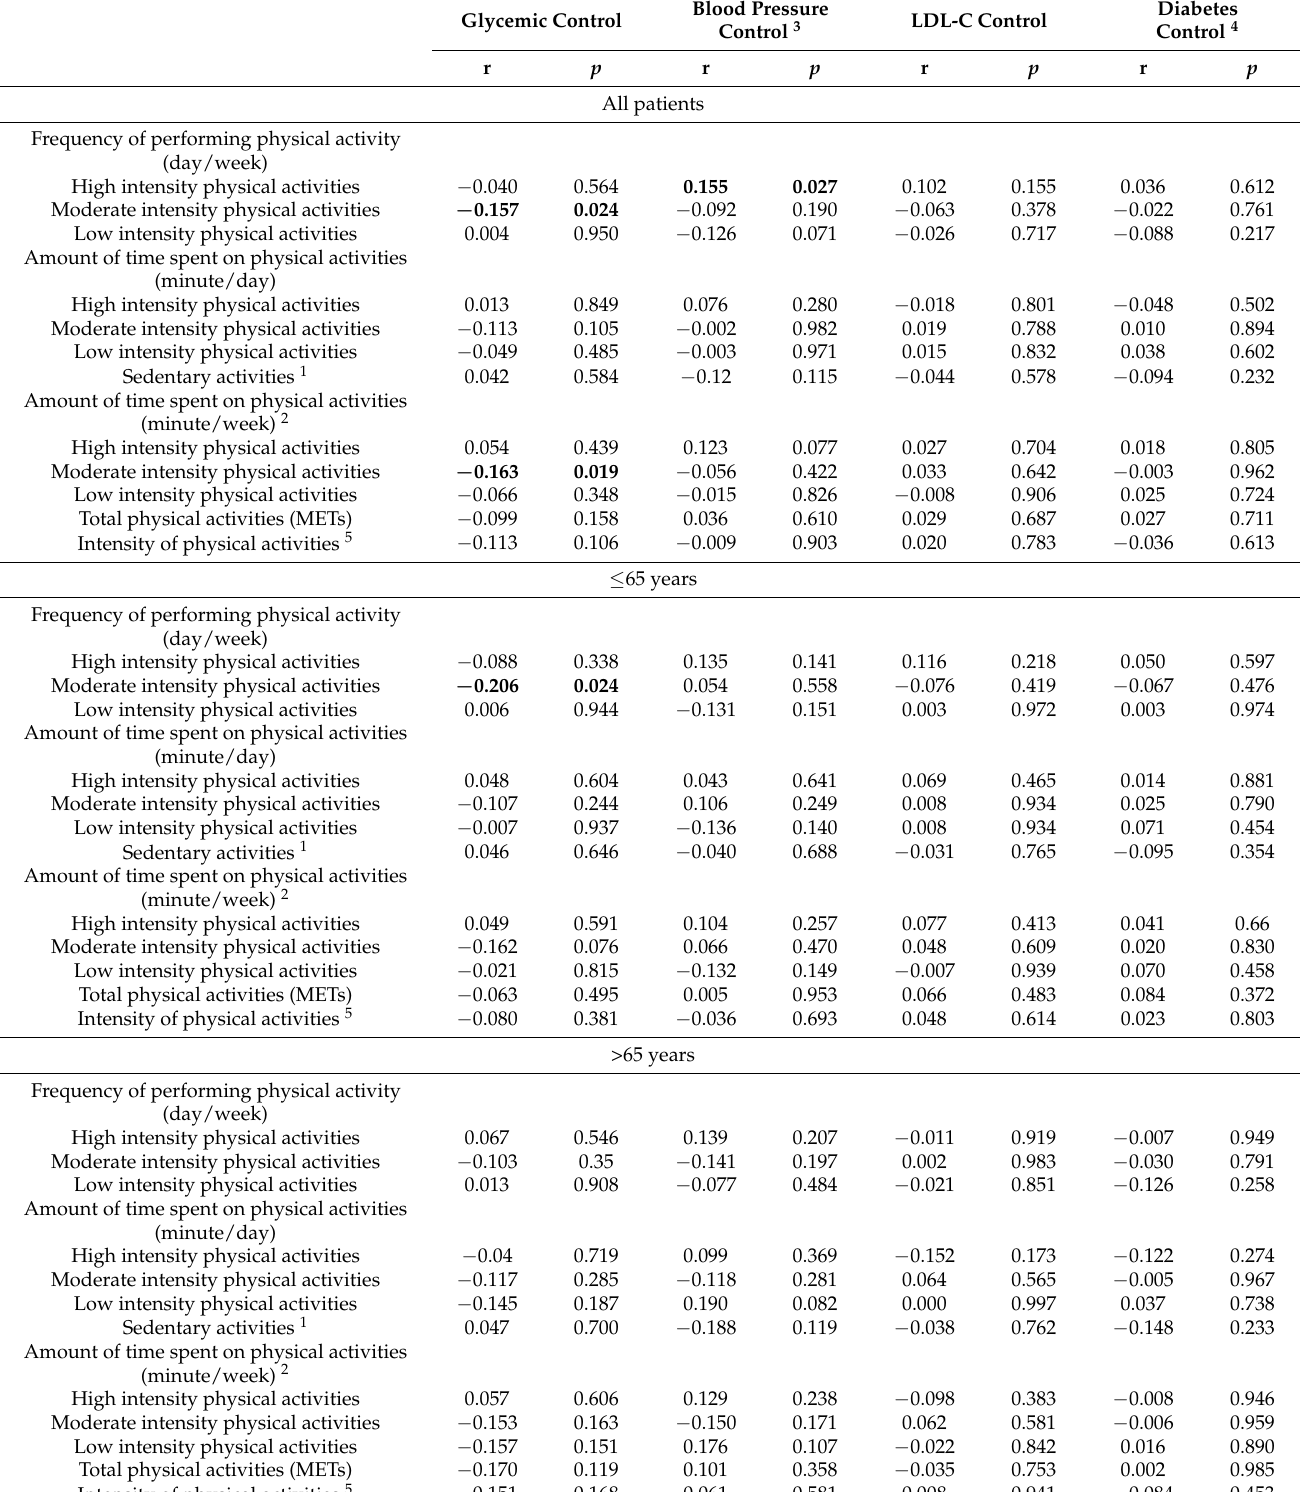
Table 3. Association of Performing Physical Activity with Diabetes Control in Patients with T2DM.